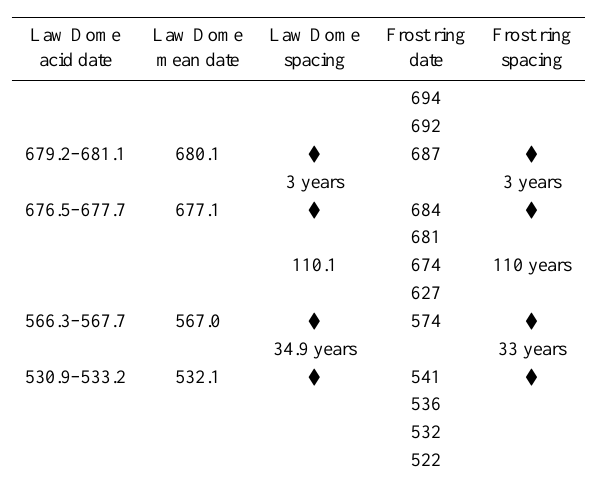
Table 1. Comparison of intervals (given by the value between suc- cessive diamonds [ (cid:7) ]) between volcanic acid layers in Law Dome, Antarctica (Plummer et al., 2012), and between frost rings in Amer- ican bristlecone pines (Salzer and Hughes, 2007) in the sixth and seventh centuries. The similarity of the intervals suggests an aver- age age offset of the Law Dome dates from the tree ring dates of 7.4